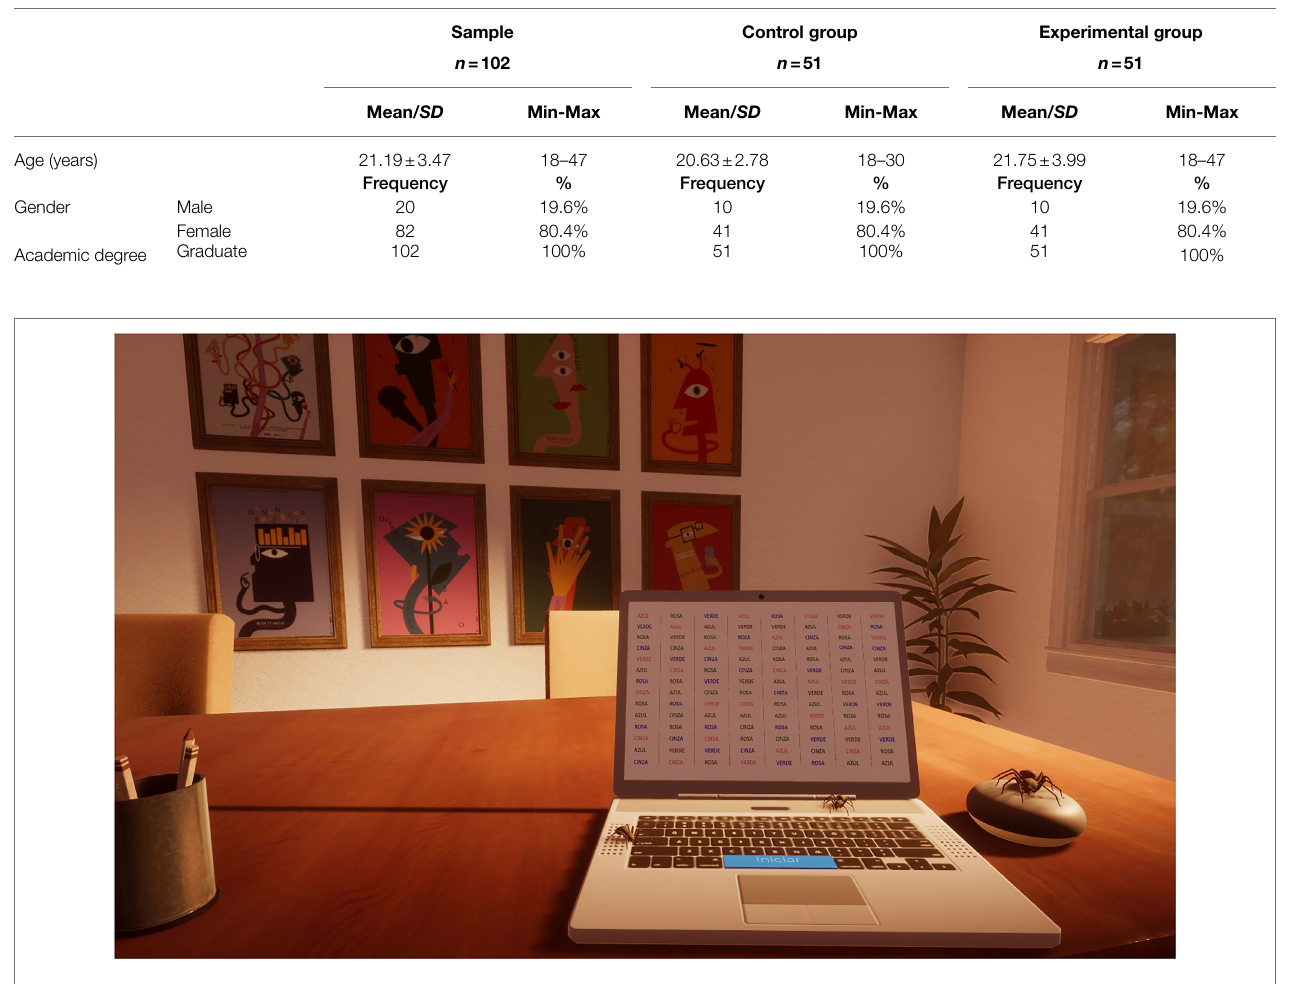
TABLE 1 | Sample sociodemographic